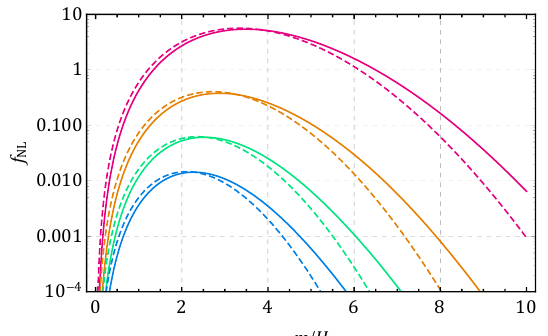
Figure 2 . The dimensionless strength of the clock signals, as functions of the fermion mass m = m=H . The 4 solid curves from bottom to top correspond to choosing (cid:3) = (5 ; 4 ; 3 ; 2) _ (cid:30) 1 = 2 e respectively, and the 4 dashed curves are corresponding approximate results of